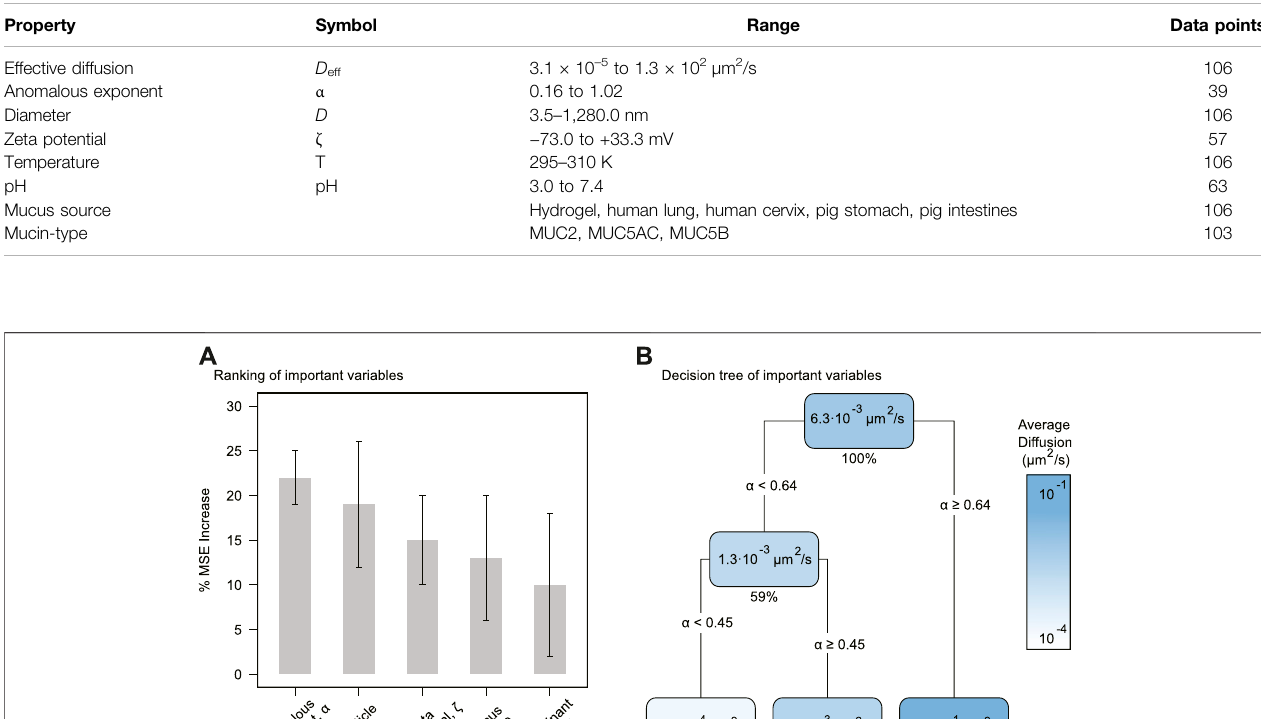
Frontiers in Physics |